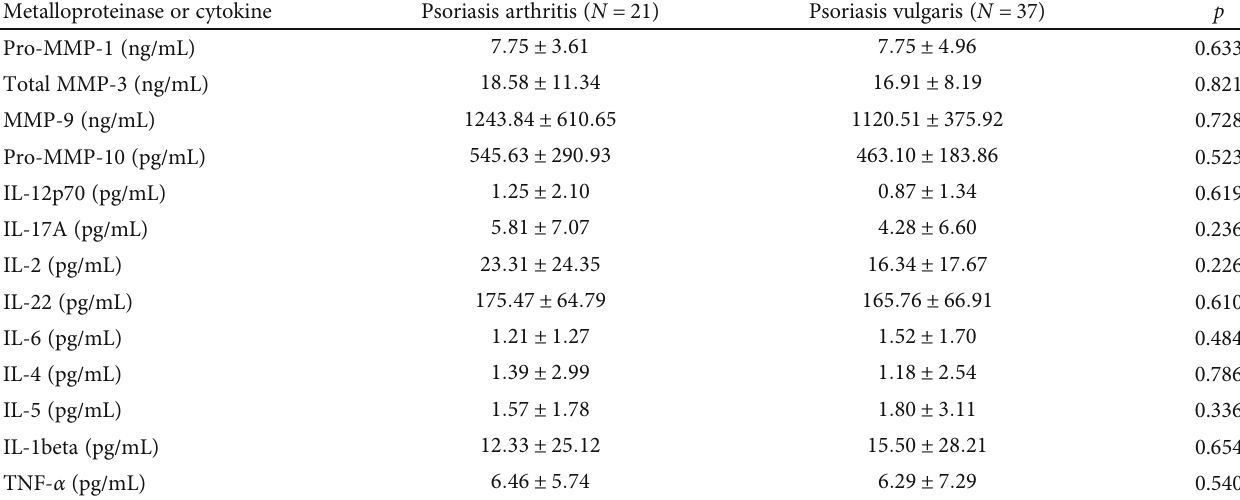
Table 3: Comparison of metalloproteinases and cytokines between psoriatic patients with and without arthritis. Metalloproteinase or cytokine Psoriasis arthritis ( N = 21